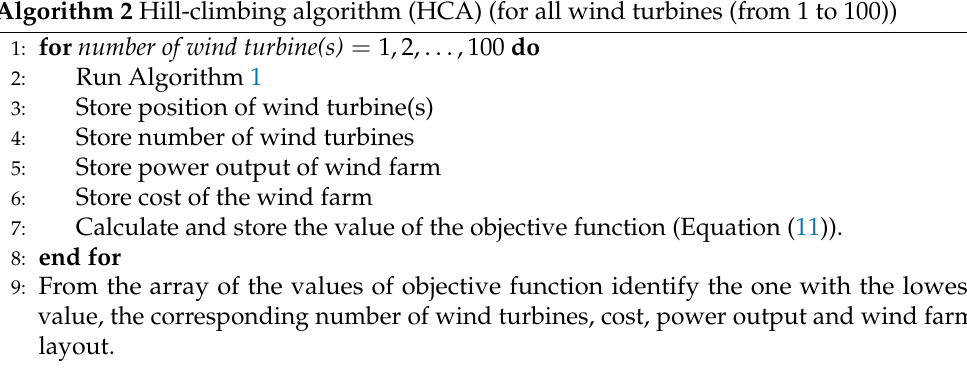
Algorithm 2 Hill-climbing algorithm (HCA) (for all wind turbines (from 1 to